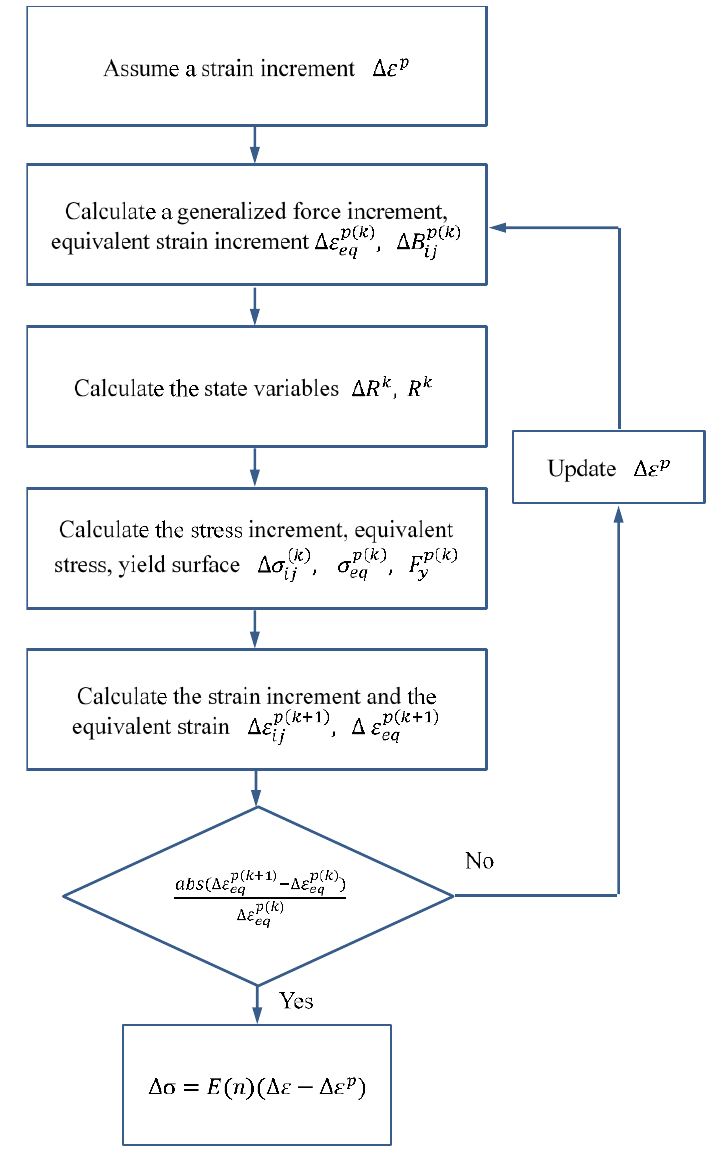
Figure 3. Flow chart of the solution of plastic stage.